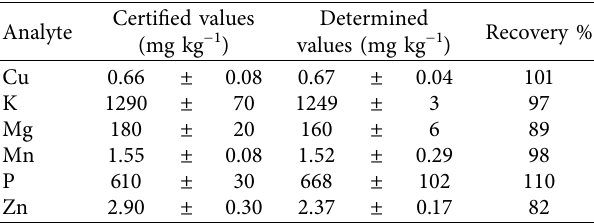
Table 3: Analyte concentration certified in reference material and determined concentrations in certified reference material ( n �